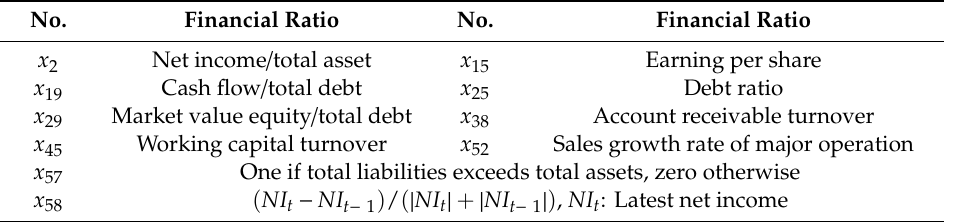
Table 2. Financial ratios selected using the energy training data set of the year ( t − 3 ) . No.